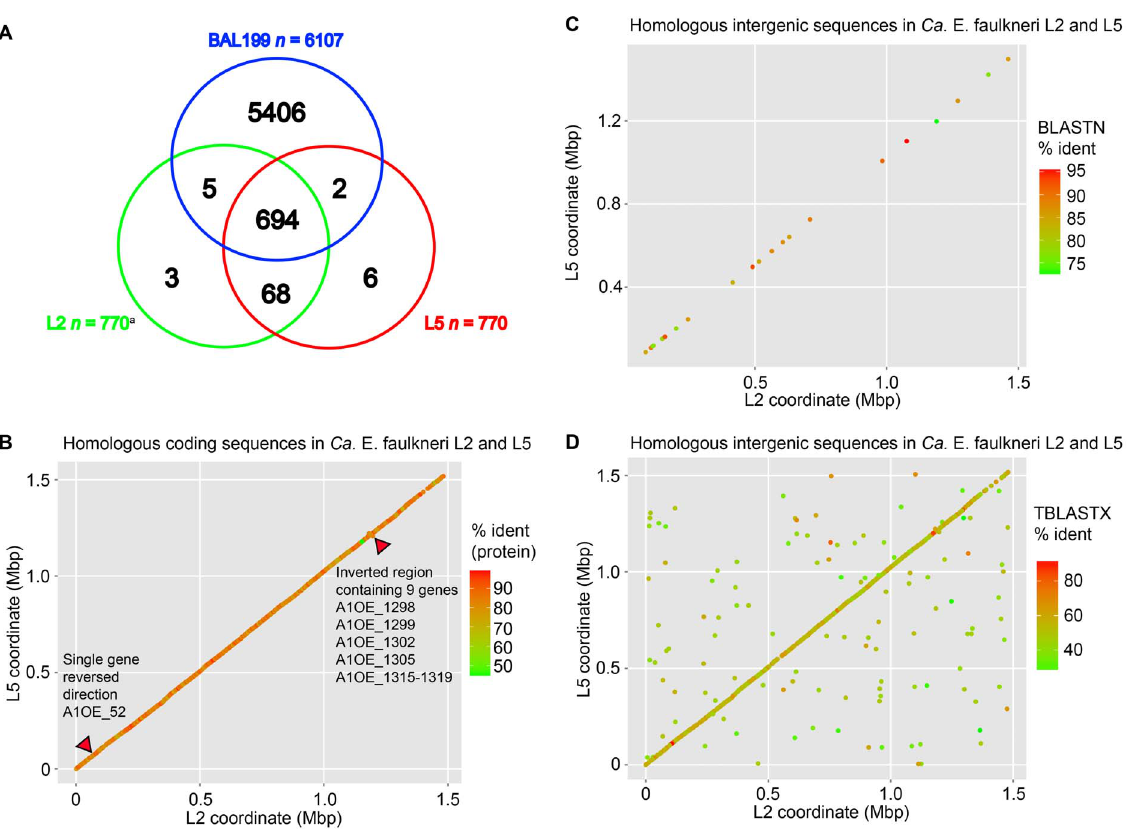
Figure 4. Ca. E. faulkneri strains L2 and L5 have very similar gene inventories and exhibit almost complete synteny. Intergenic sequences are highly degraded, but still show a strong syntenic signal, indicating that they were once functional genes. (A) Venn diagram of homologous proteins in Ca. E. faulkneri L2, L5 and a -proteobacterium BAL199. (B) Synteny plot of proteins in Ca. E. faulkneri L2 and L5. (C) Synteny plot of homologous intergenic sequences in Ca. E. faulkneri L2 and L5 identified by BLASTN searches. (D) Synteny plot of homologous intergenic sequences in Ca. E. faulkneri L2 and L5 identified by TBLASTX searches (see Materials and Methods). aFor the purposes of the Venn diagram, the number of protein coding genes in Ca. E. faulkneri is given as 770, because A1OE_1073 and A1OE_1074 are both homologous to P856_600 (see Main Text).